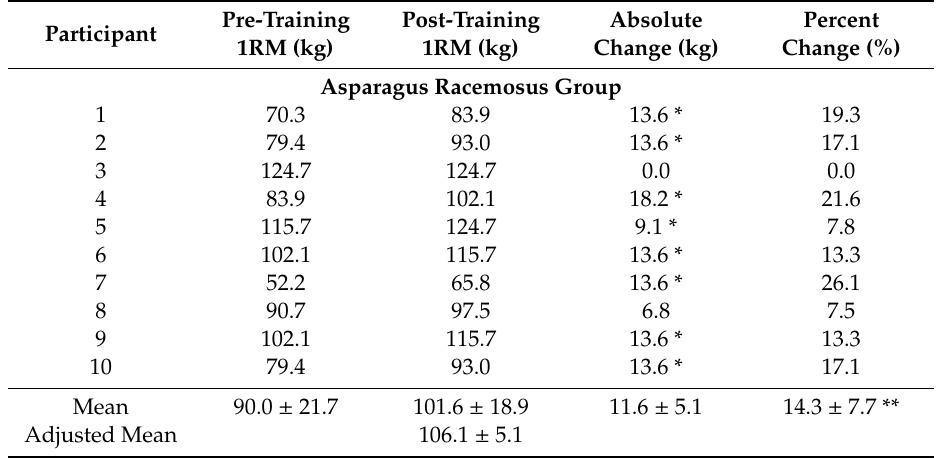
Table 4. Individual values as well as absolute and adjusted mean ± SD values for pre-training and post-training bench press